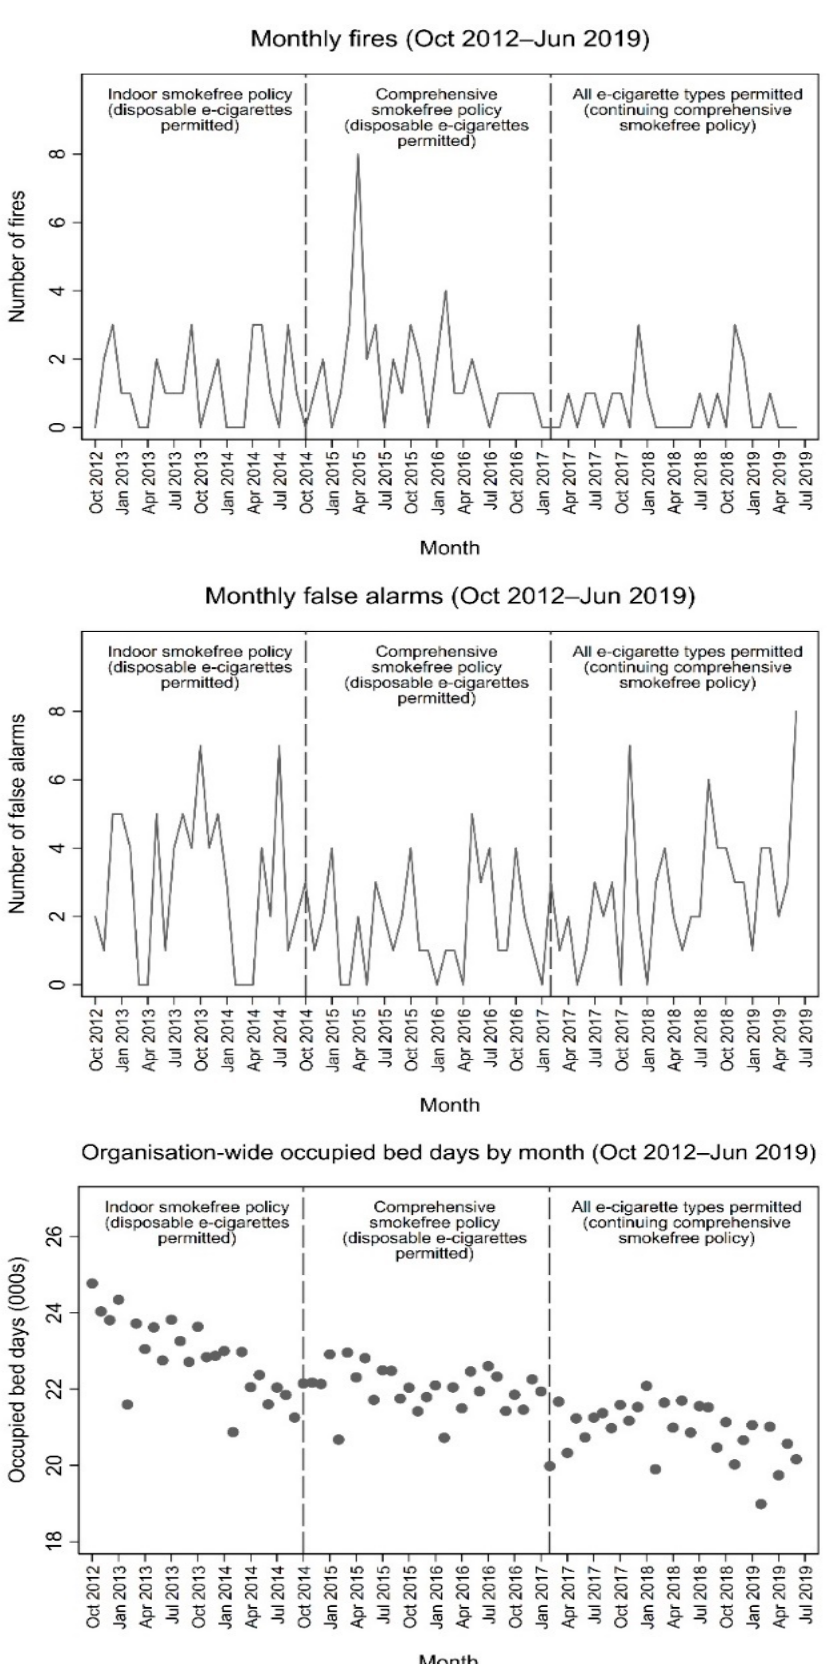
Figure 1. Organisation-wide monthly fires, false alarms (line graphs) and occupied bed days (scatterplots) during each policy condition (October 2012–June